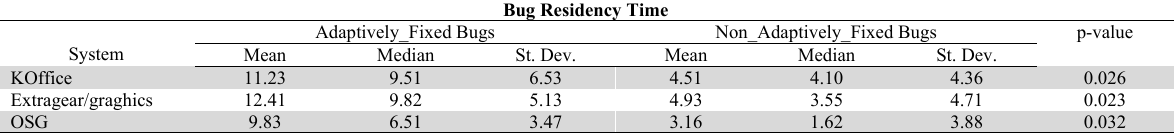
Bug Residency Time (E.G., #Months) In Adaptively_Fixed And Non_Adaptively_Fixed Bugs: Descriptive Statistics And Mann-Whitney Test (P-Value)